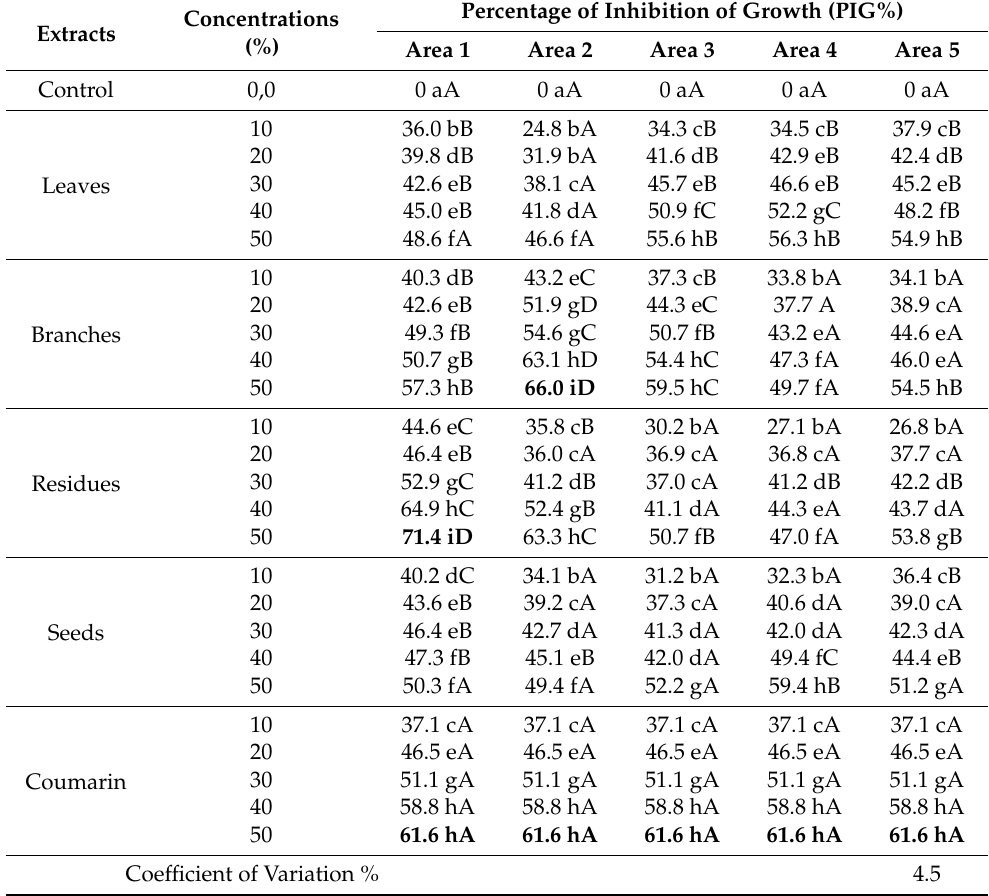
Table 2. Percentage of inhibition of growth (PIG) of Colletotrichum musae submitted to different concentrations of Dipteryx punctata ethanol extracts and coumarin